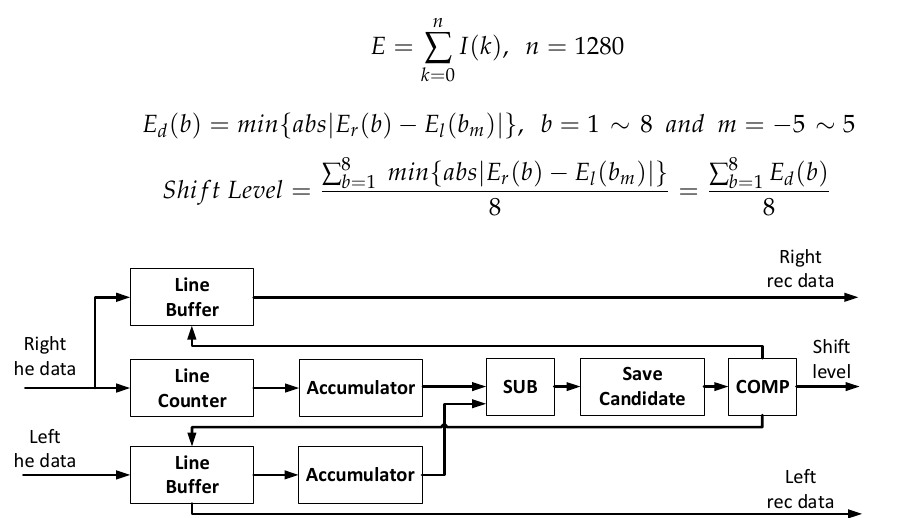
Figure 4. Hardware architecture of image rectification.